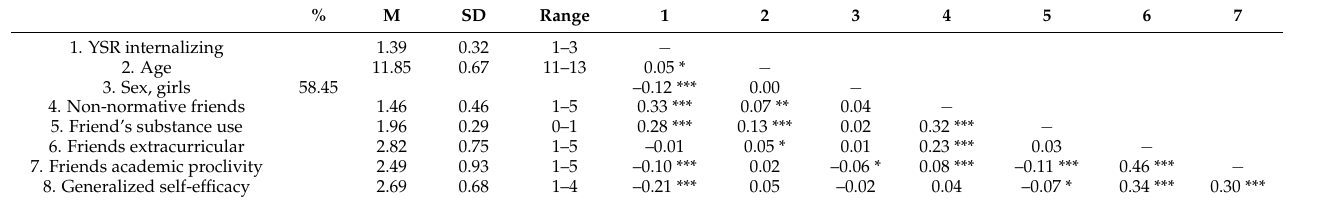
Table 1. Means, standard deviations, ranges, and intercorrelations among study variables (N =